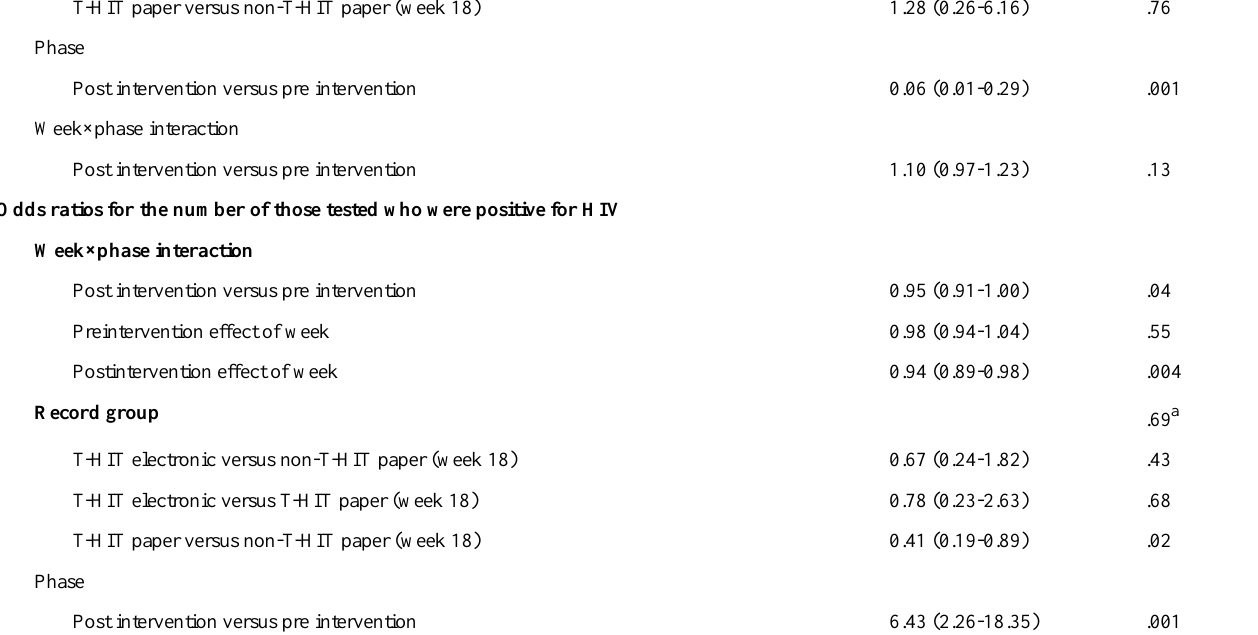
Odds ratios for the number of patients who were tested for